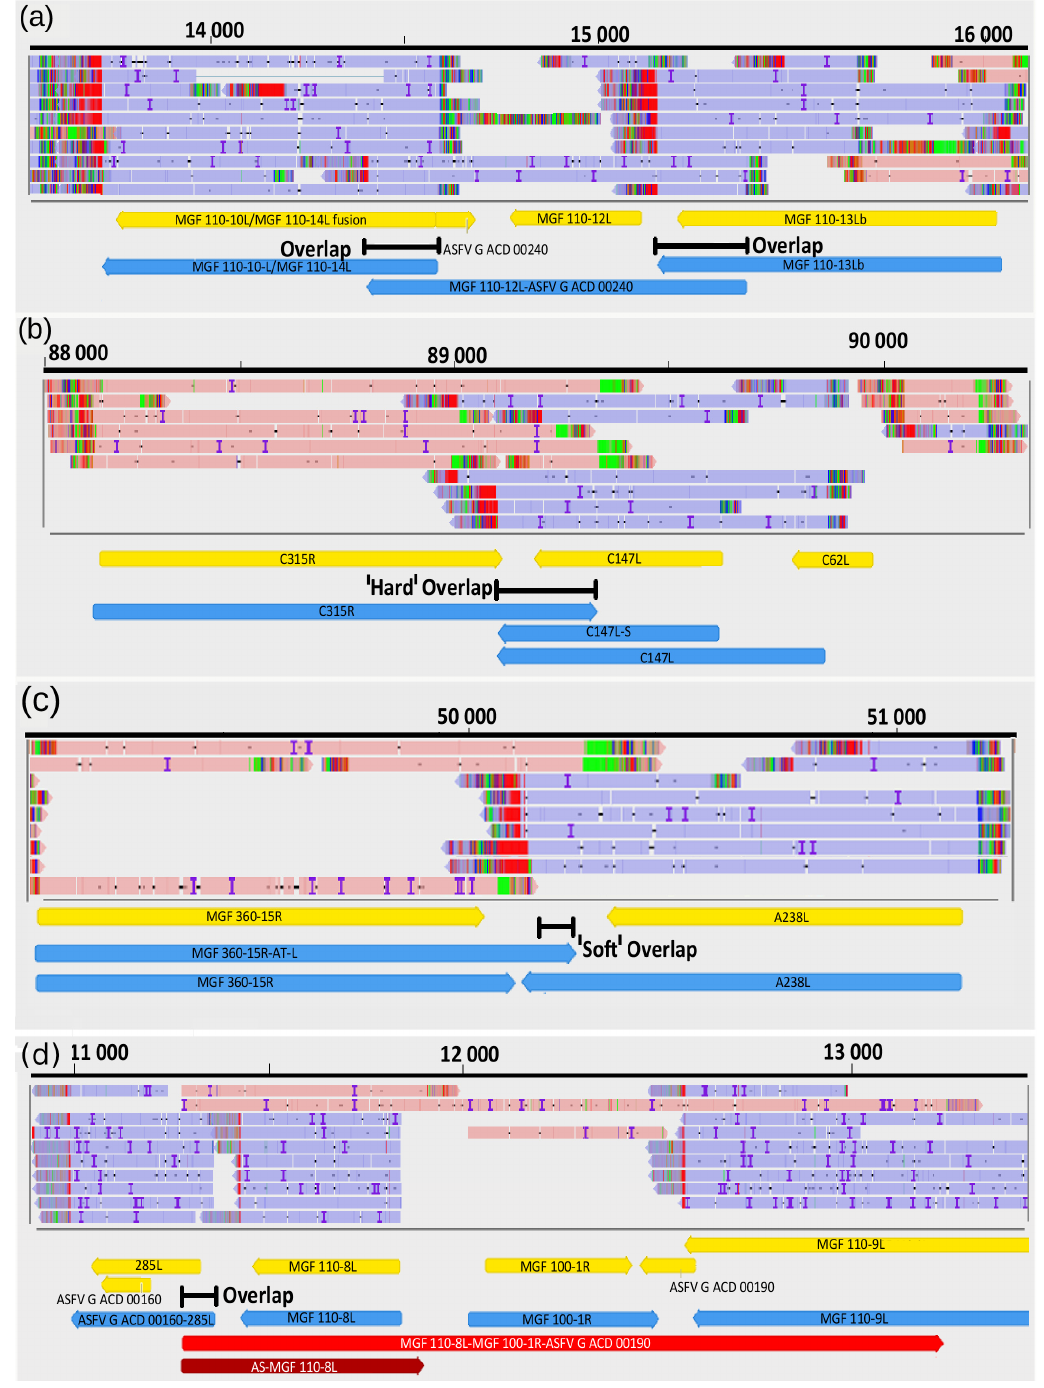
Figure 5. Examples for transcription overlaps of ASFV RNA molecules. ( a ) parallel overlaps, ( b ) convergent "hard" overlap ( c ) convergent "soft" overlap, ( d ) divergent overlap.